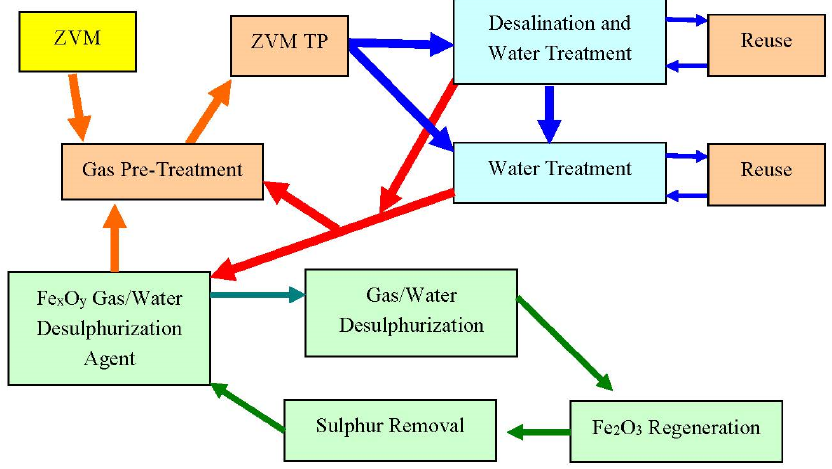
Figure 18. Example Life Cycle of a batch of ZVM TP which is used to desalinate